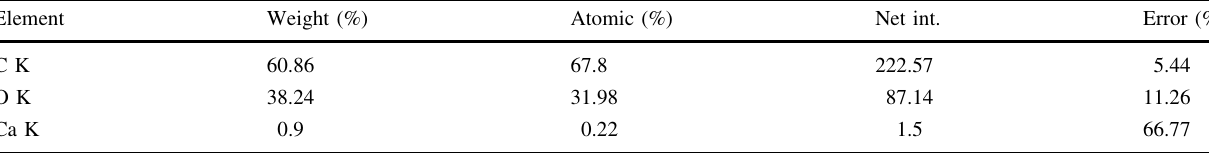
Table 2 Various elements present onto the tea waste biomass after surface modification Element